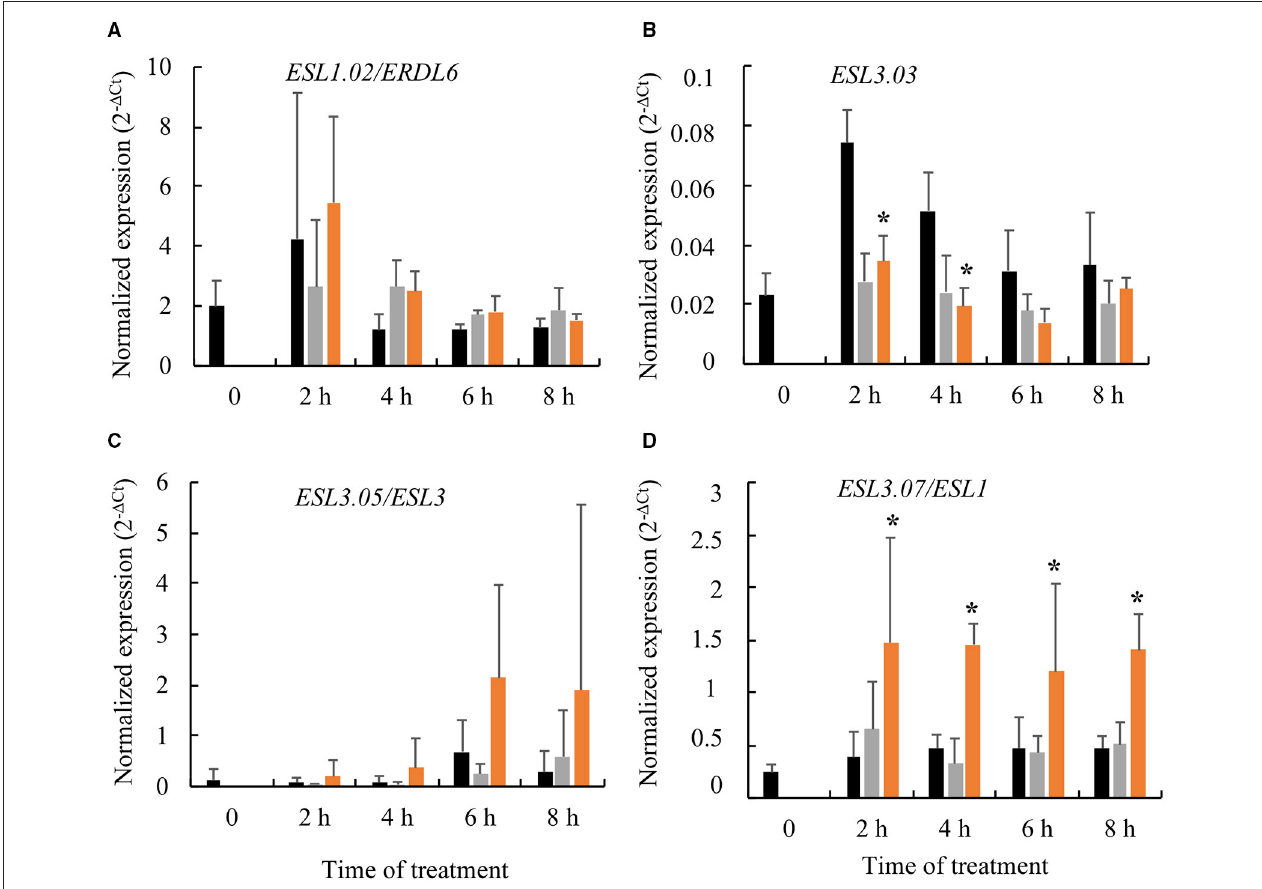
FIGURE 6 | Relative expression of four AtESL genes in response to abscisic acid (ABA) pulverization on leaves of A. thaliana Col-0. Black: control, Gray: DMSO, Orange: DMSO + ABA (750 µ M). (A) ESL1.02/ERDL6 , (B) ESL3.03 , (C) ESL3.05/ESL3 , and (D) ESL3.07/ESL1 . 2 − 1 Ct values are normalized according to AtPP2a expression and represent the mean of three biological repeats ( ± SD). The asterisks represent the significantly different values determined by the Kruskal–Wallis test followed by Dunn’s multiple comparisons test ( p < 0.05) with the Bonferroni